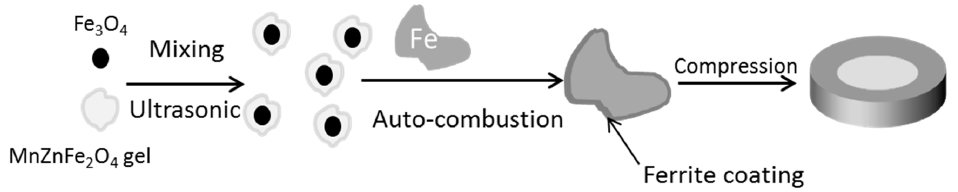
Figure 1. Procedure for Fe 3 O 4 and MnZn ferrite insulation coated iron powder.